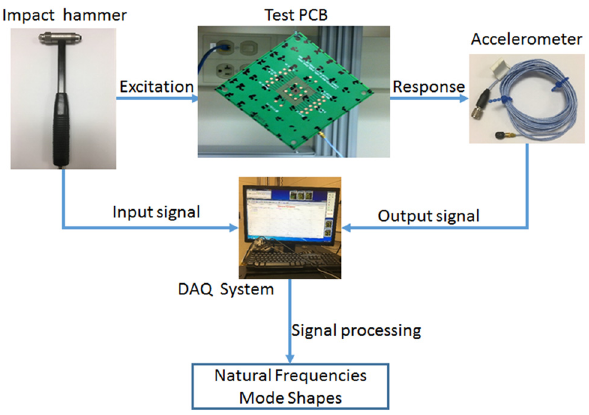
Figure 4: Modal analysis experiment.